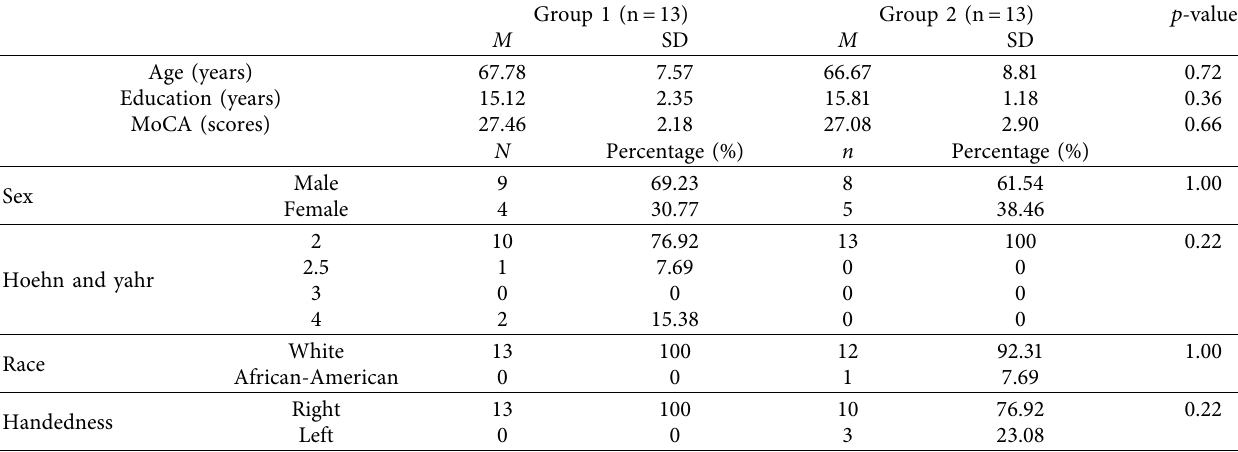
Table 1: Participant characteristics.